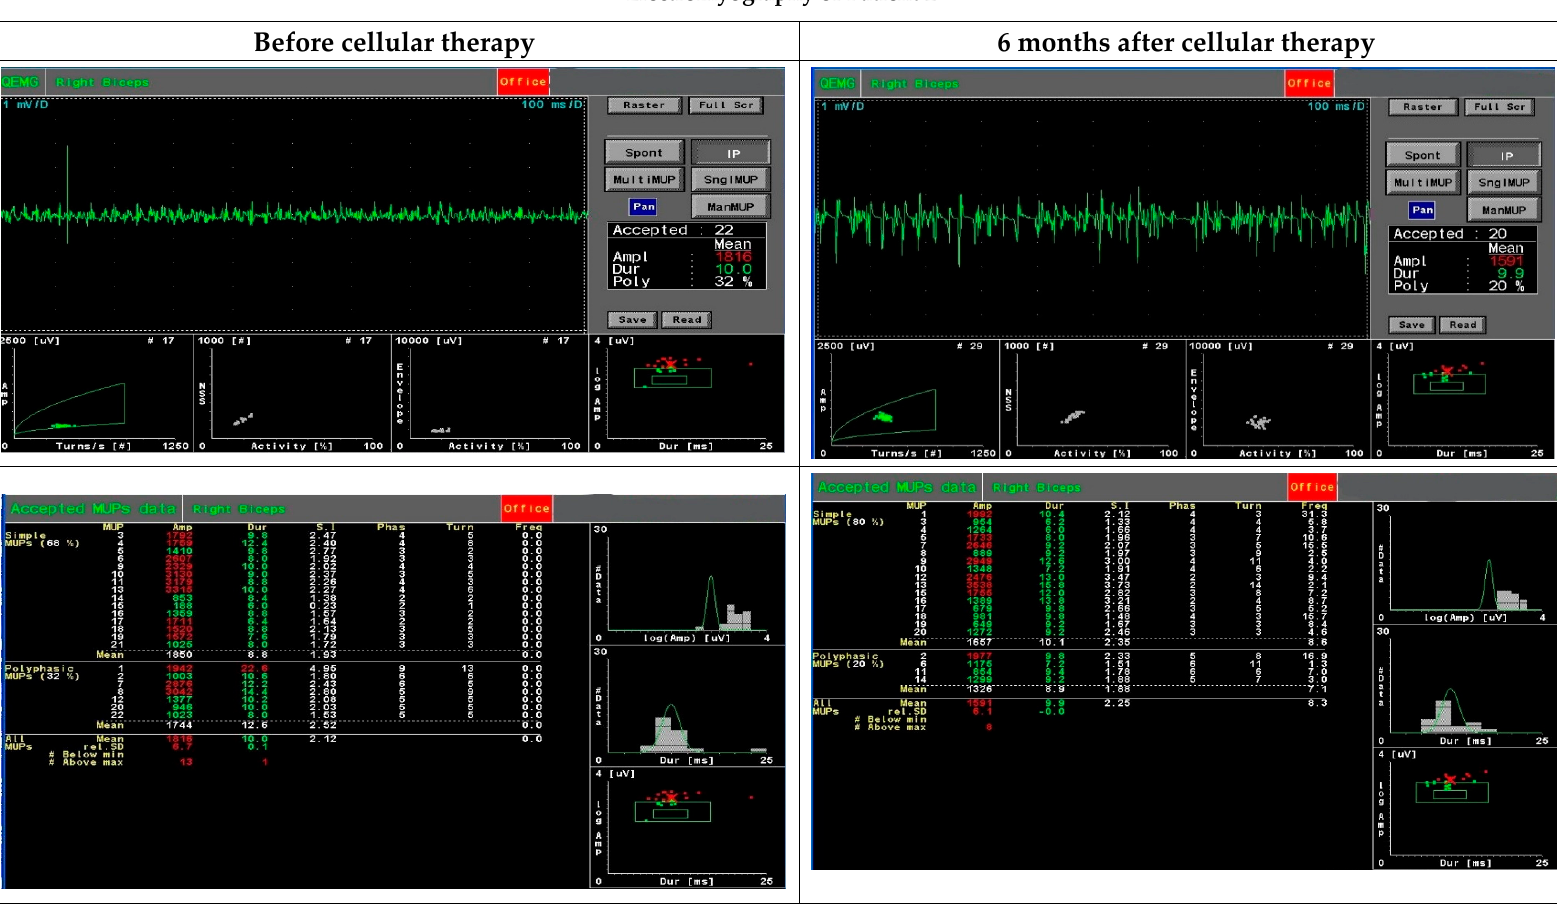
Figure 2. Functional assessment performed with electromyography before and six months after cellular therapy in Patient 2 revealed an improvement in motor unit parameters, especially area and size index.